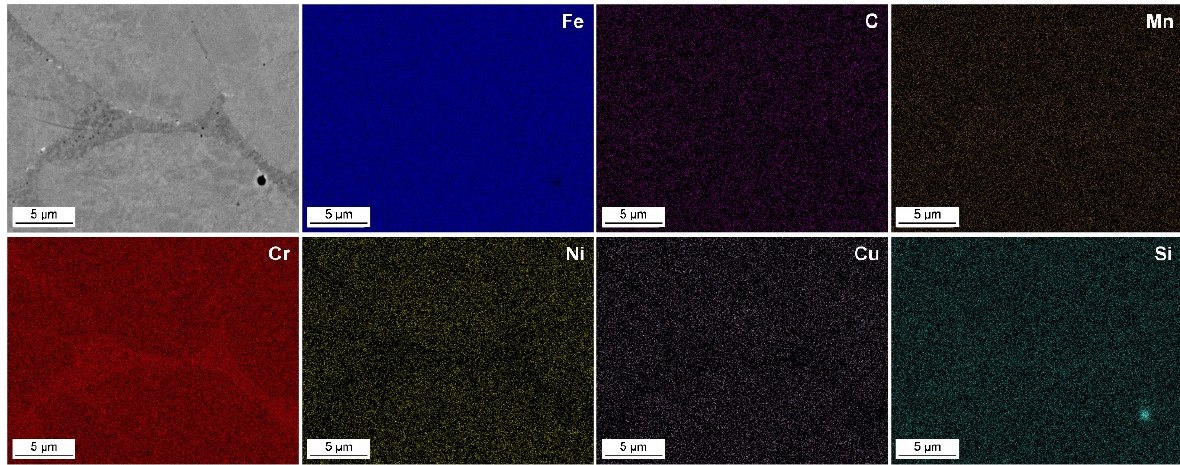
Figure 10. Compositional mapping analysis of the PMD specimen built in an argon atmosphere.